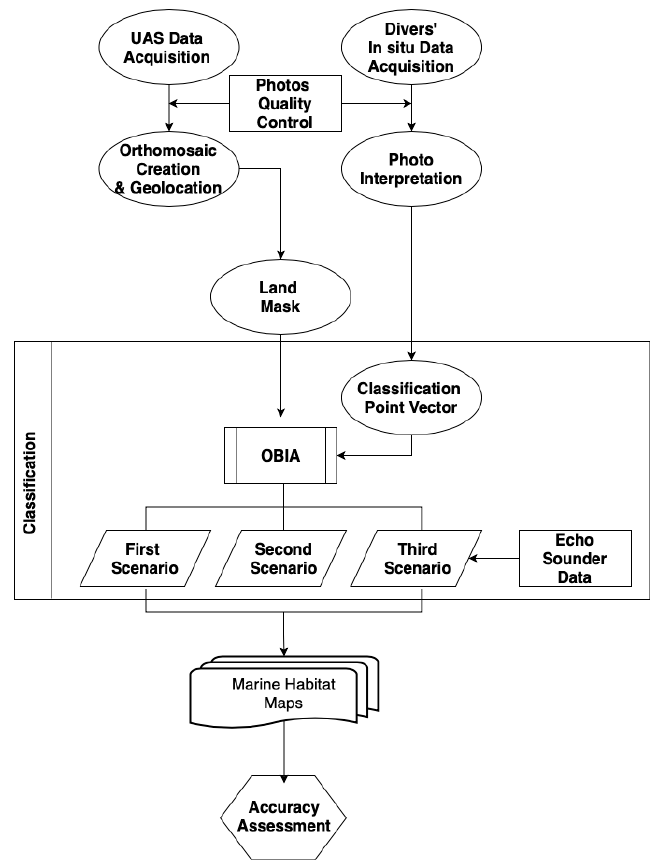
Figure 5. Methodological workflow. UAS: unmanned aircraft system. OBIA: object-based image analysis.